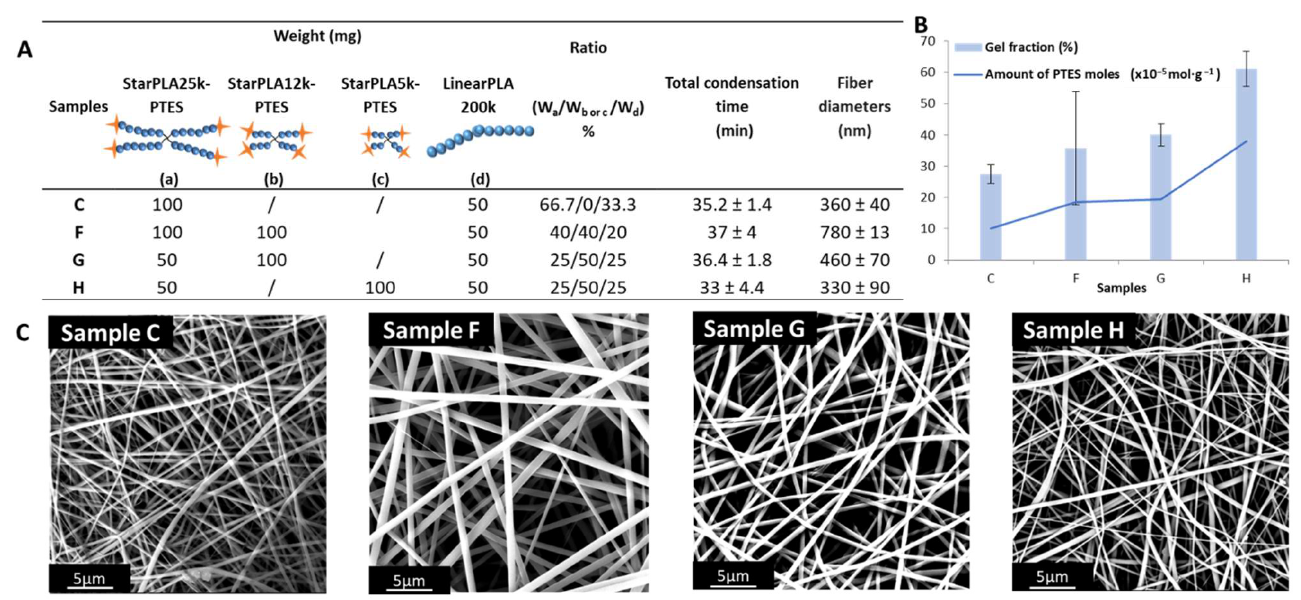
Figure 3. Effect of the density of PTES groups on the crosslinking efficiency of the nanofiber network: ( A ) Influence of molecular weight of the added polymer on the total condensation time and fiber diameter; ( B ) Evolution of the gel fraction as a function of the density of PTES groups; ( C ) SEM images of samples C, F, G and H .